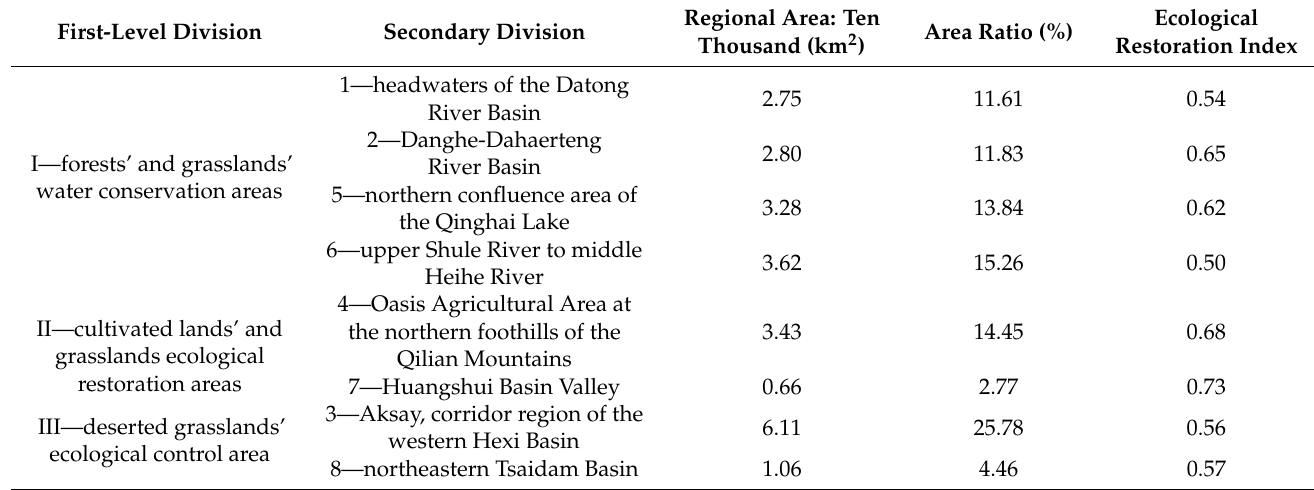
Figure 6. Ecological restoration zoning of the Qilian Mountains. Zoning 1 represents the headwaters of the Datong River Basin; Zoning 2 represents the Danghe-Dahaerteng River Basin; Zoning 3 rep- resents Aksay (corridor region of the western Hexi Basin); Zoning 4 represents the Oasis Agricul- tural Area at the northern foothills of the Qilian Mountains; Zoning 5 represents the northern con- fluence area of the Qinghai Lake; Zoning 6 represents the upper Shule River to middle Heihe River; Zoning 7 represents the Huangshui Basin Valley; and Zoning 8 represents the northeastern Tsaidam Basin.